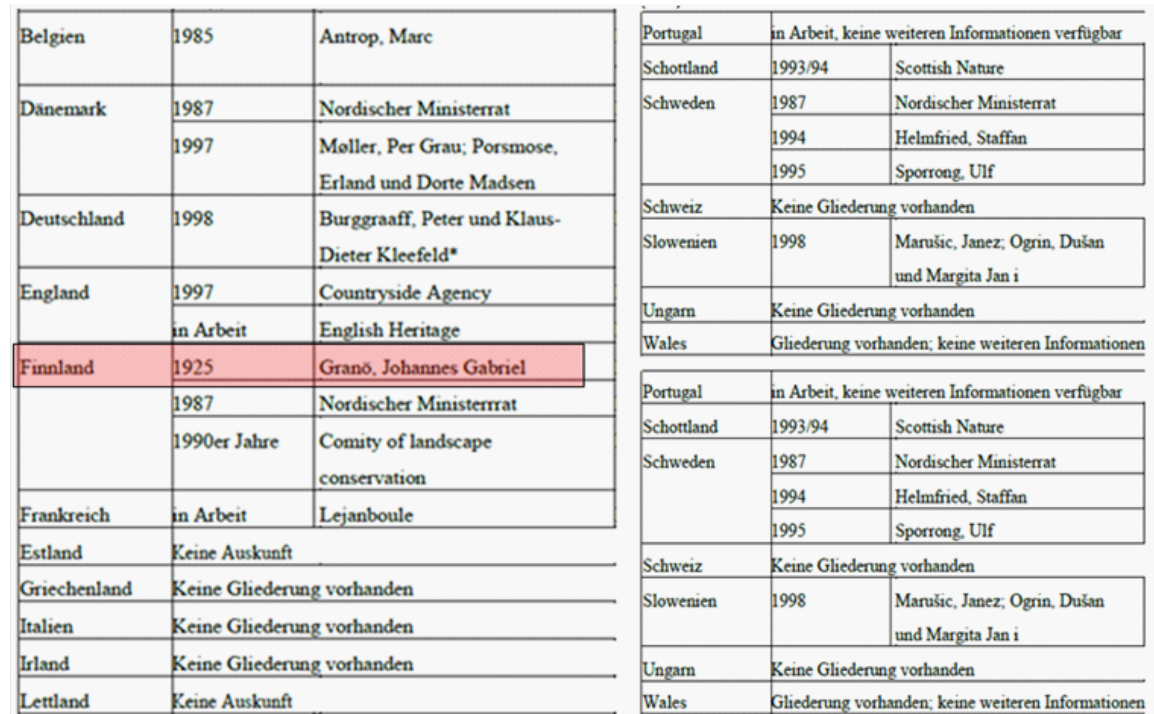
Table 1: Overview of the national landscape structure and its classificationsin Europa 2003 (Jeschke & Mandl, 2012),